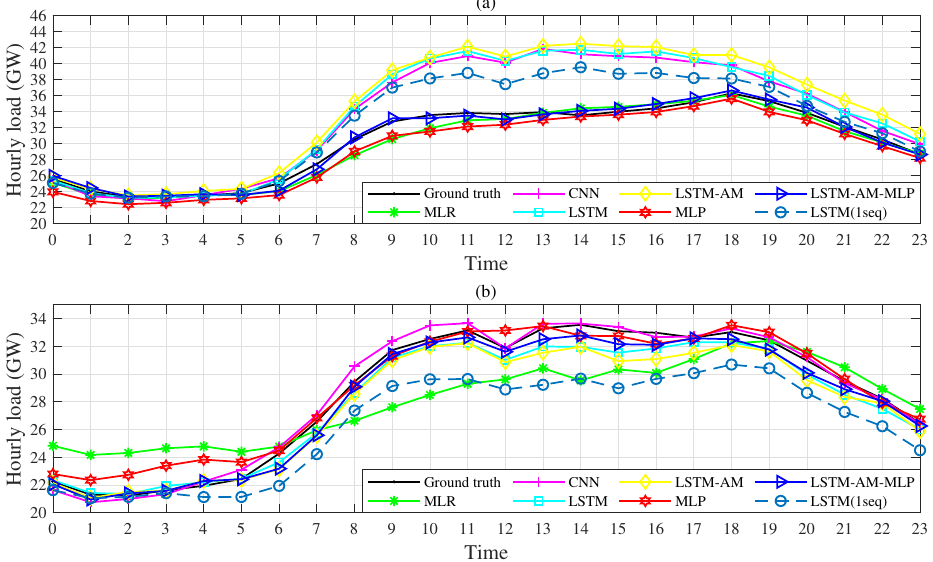
Figure 6. Forecasting results of different models on a specific holiday ( a ) and a workday ( b ). The value at time 0 represents the mean load over 0:00 ∼ 1:00